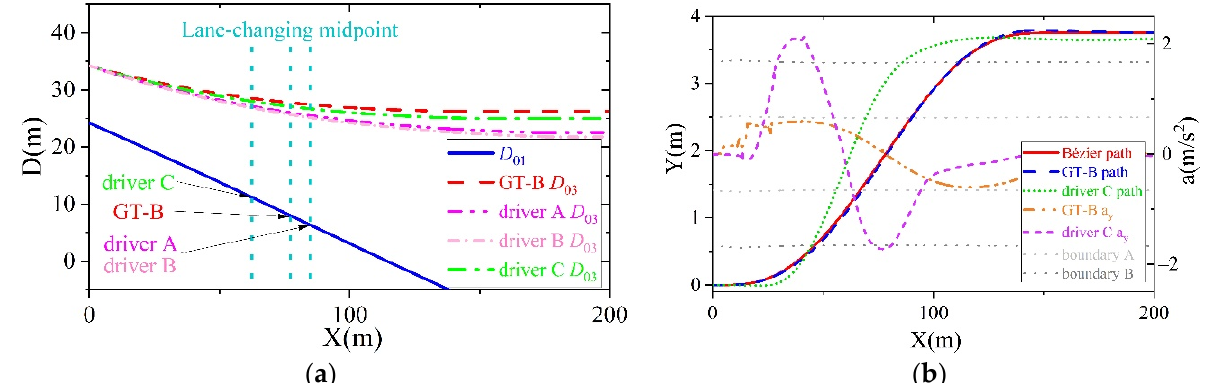
Figure 14. Vehicles’ interval, path and lateral acceleration in Case II. ( a ) Vehicle interval during lane-changing by different drivers. ( b ) Vehicle path and lateral acceleration.